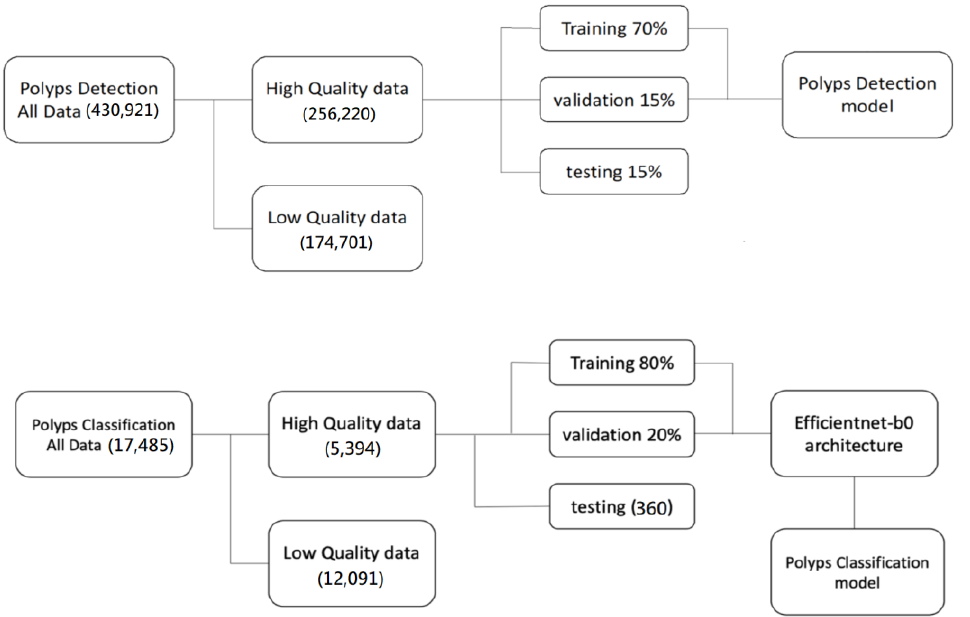
Figure 1. Flowchart illustrating the polyp detection and classification approach for the proposed